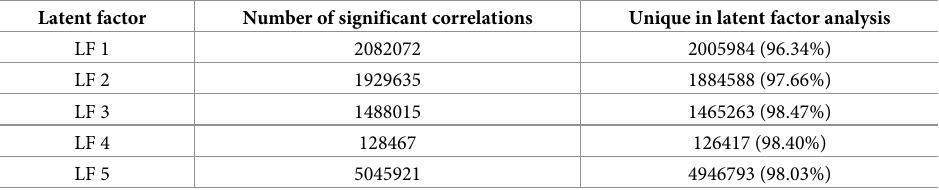
Table 4. Summary of total number of significant correlations in each